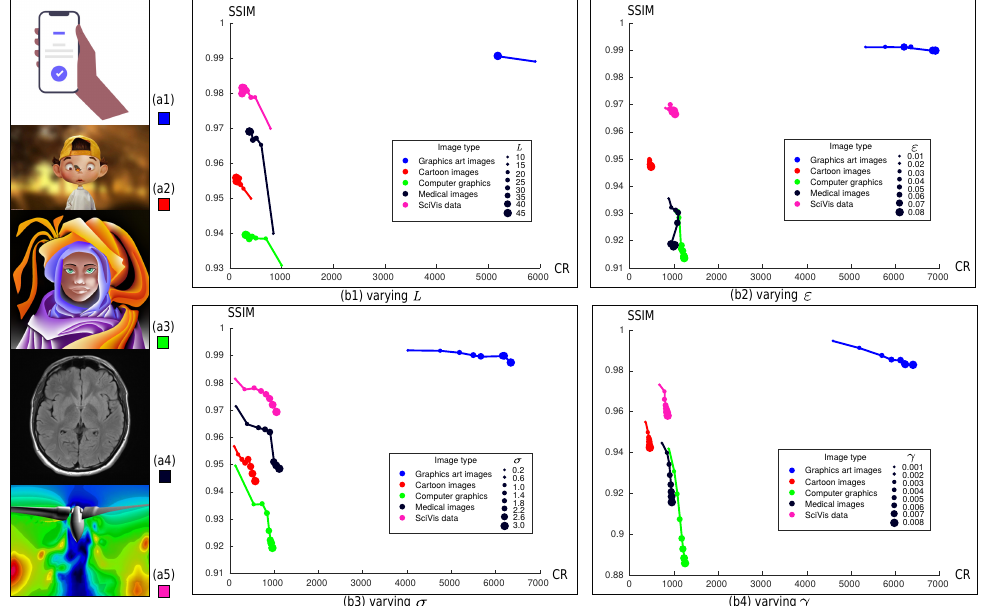
Figure 9. Trade-off between Q (SSIM) and CR for five image types ( a1 – a5 ) as a function of parameters L ( b1 ), ε ( b2 ), σ ( b3 ), and γ ( b4 ), respectively. The box colors in ( a1 – a5 ) corresponds to the five colors of scatterplots in ( b1 – b4